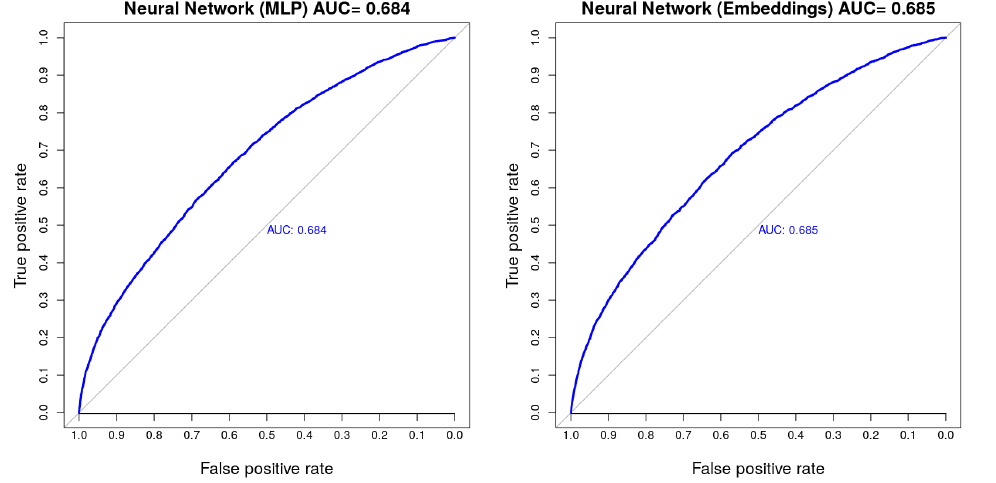
Figure 4. AUC values on the test set achieved using a neural network with feature normalization ( left ) and feature normalization + categorical embeddings ( right